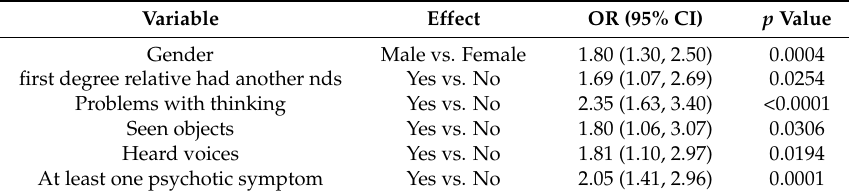
Table 2. Multiple logistic regression results among all subjects.